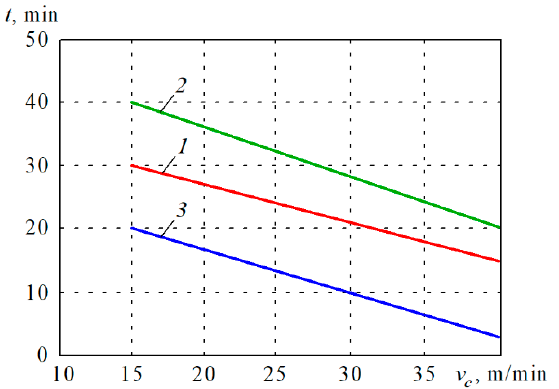
Figure 9. Durability of cutting inserts at different cutting speeds when machining TiC/Fe composite: 1—WolCar, 2—CBN, 3—BK8.